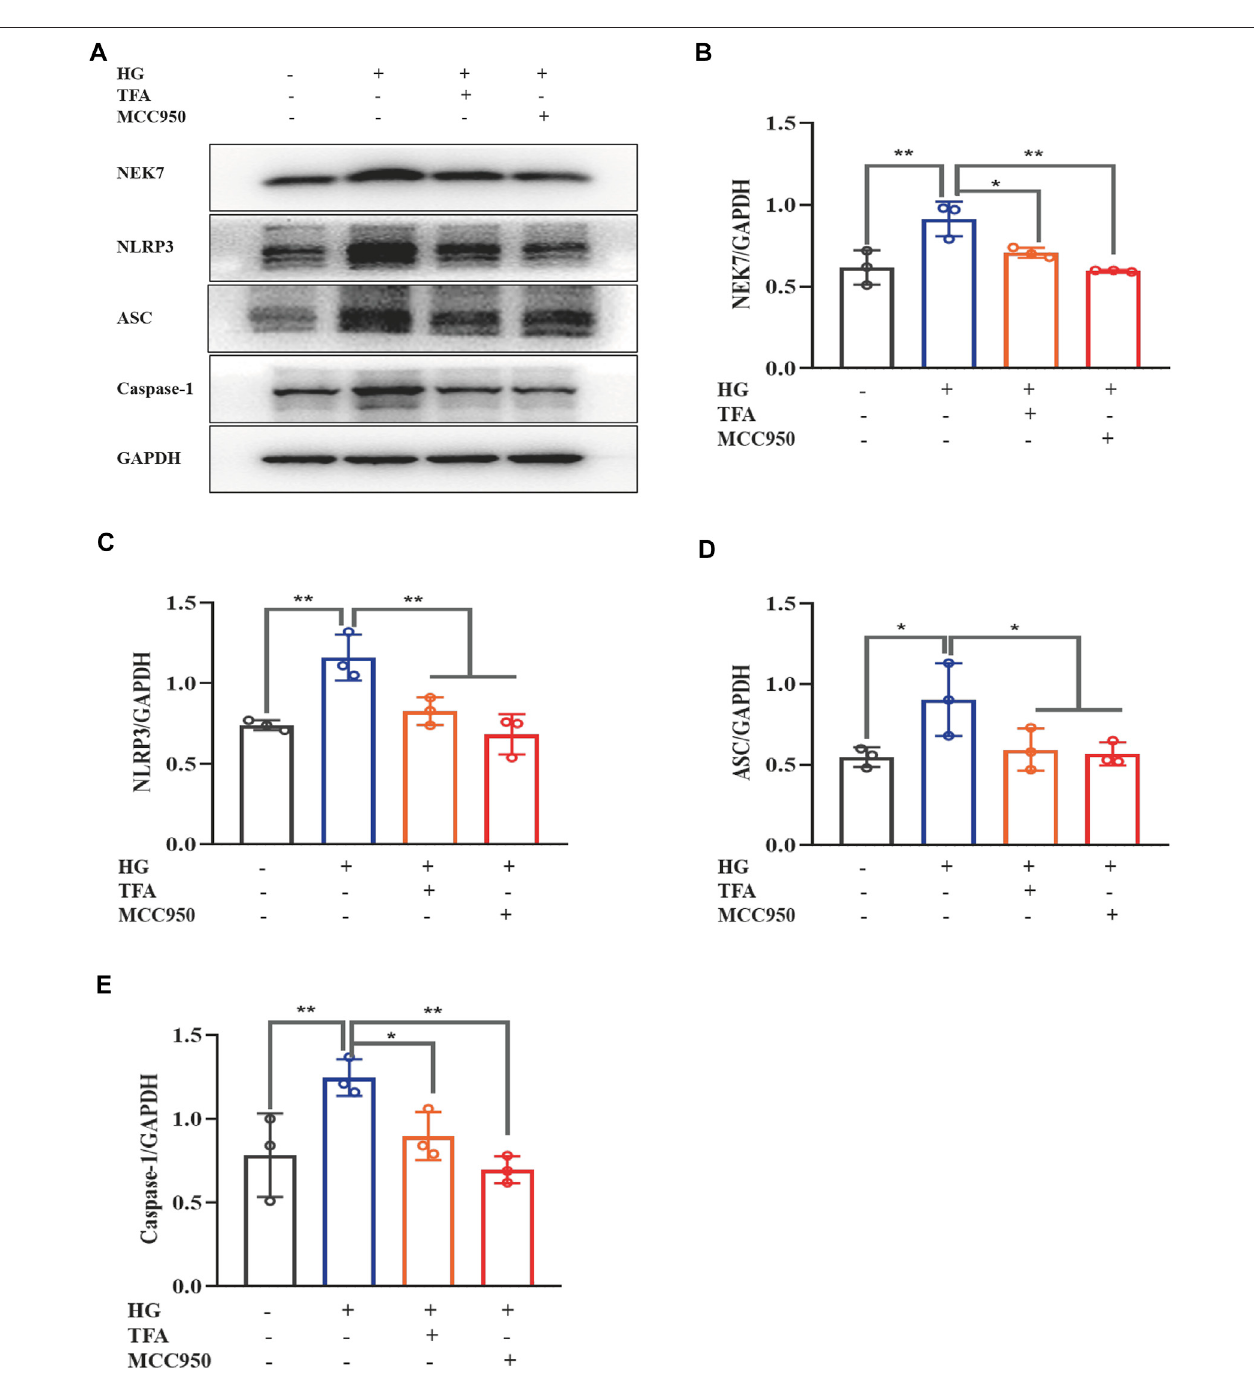
FIGURE 3 | TFA and MCC950 attenuated HG-induced in fl ammasome activation in MPC-5 cells. (A) WB analysis of NEK7, NLRP3, ASC, and caspase-1, in cultured MPC-5 cells exposed to HG at 30 mM for 48 h with or without TFA (20 μ g/ml) and MCC950 (10 μ M) treatment for 24 h; (B) NEK7 was quanti fi ed by densitometry; (C) NLRP3 was quanti fi ed by densitometry; (D) ASC wasquanti fi ed by densitometry; (E) Caspase-1 was quanti fi ed bydensitometry.Data are expressed as mean ± S.D., ( n (cid:2) 3). * p < 0.05, ** p < 0.01. Abbreviations: TFA, total fl avones of Abelmoschus manihot ; HG, high glucose; MPC-5, mouse podocyte cell-5; WB, western blotting; NEK7, NIMA-related kinase 7; NLRP3, NOD-like receptor pyrin domain-containing protein 3; ASC, a C-terminal caspase recruitment domain; Caspases-1, cysteinyl aspartate-speci fi c proteinase-1.